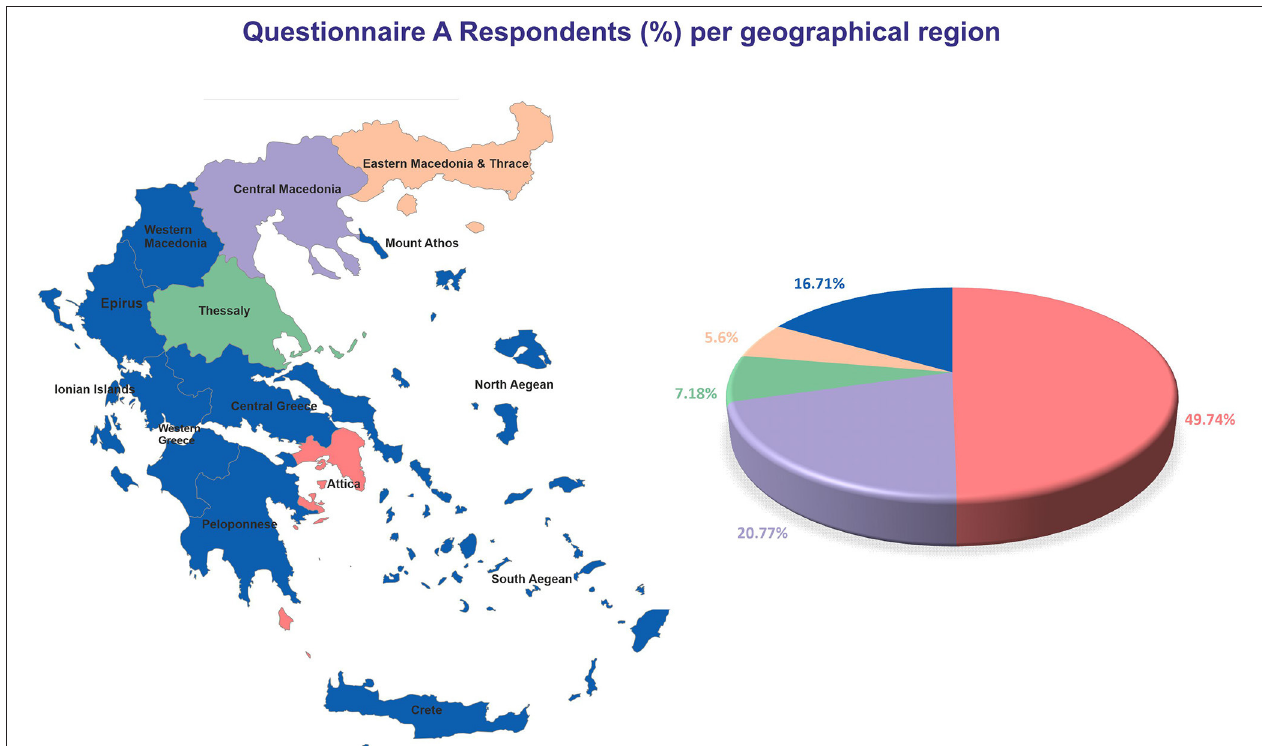
FIGURE 1 | Geographical distribution of respondents for Questionnaire